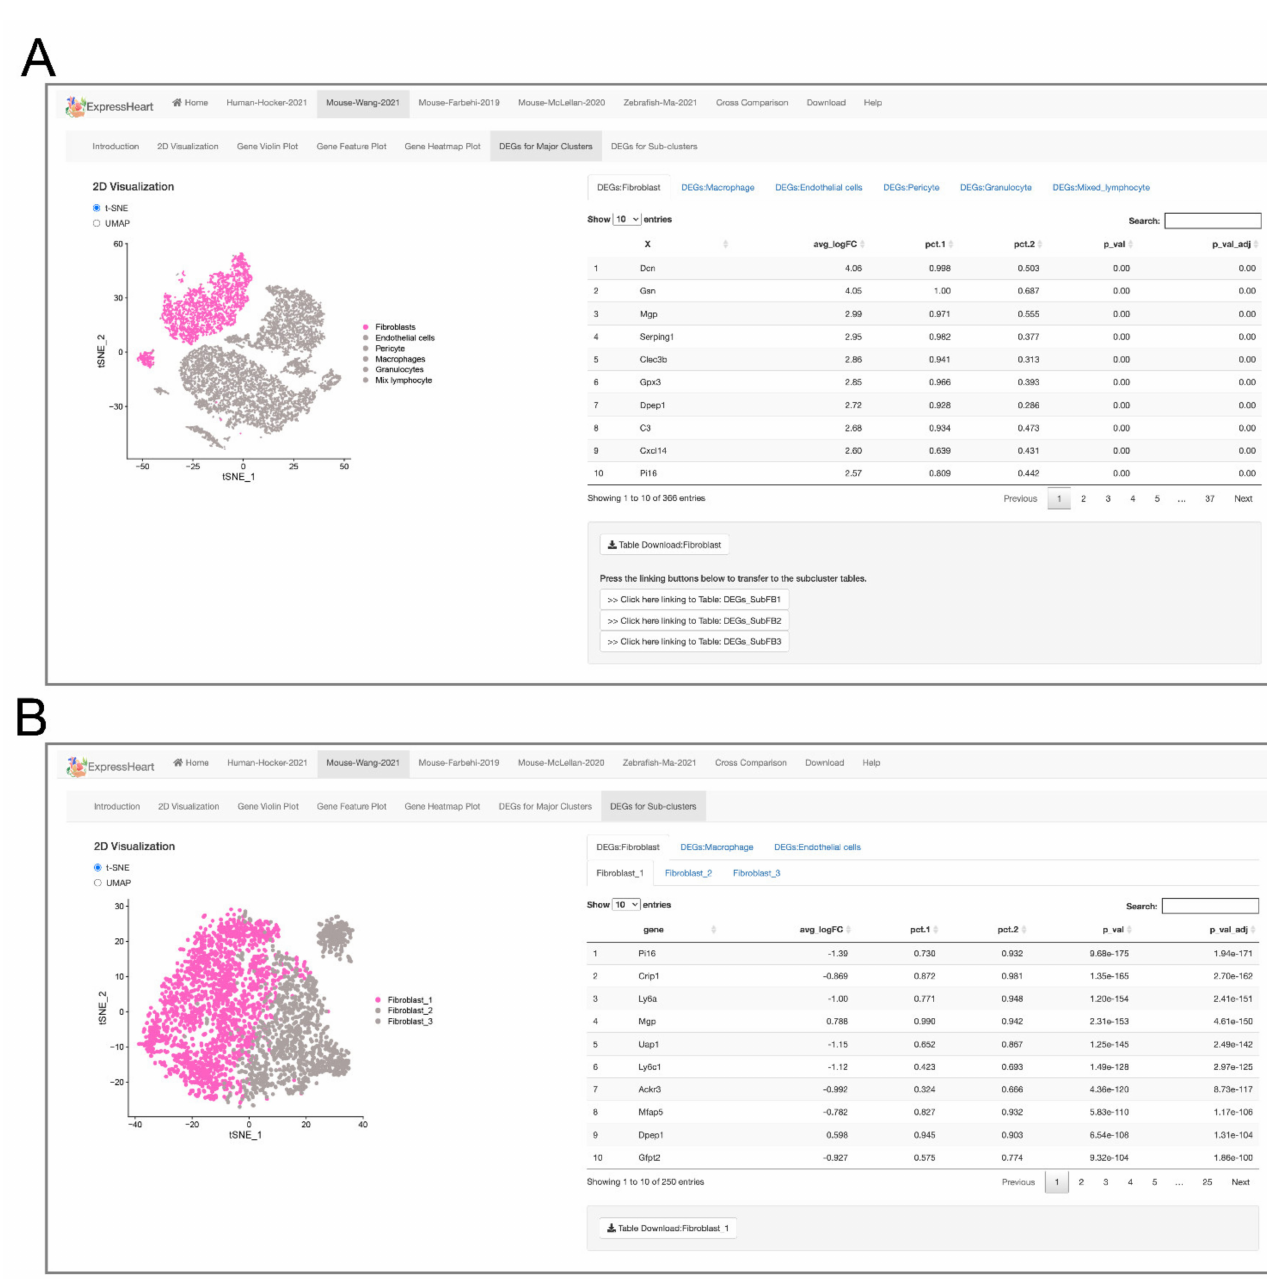
Figure 4. Interfaces of DEG lists for ( A ) each major cell type versus the other cell types, and ( B ) each subtype versus the other subtypes the same major cell type. On the left panel of each interface, the UMAP/t-SNE plot highlighting the target major cell type ( A ) or subtype ( B ) is presented, and the corresponding DEGs are listed in a table on the